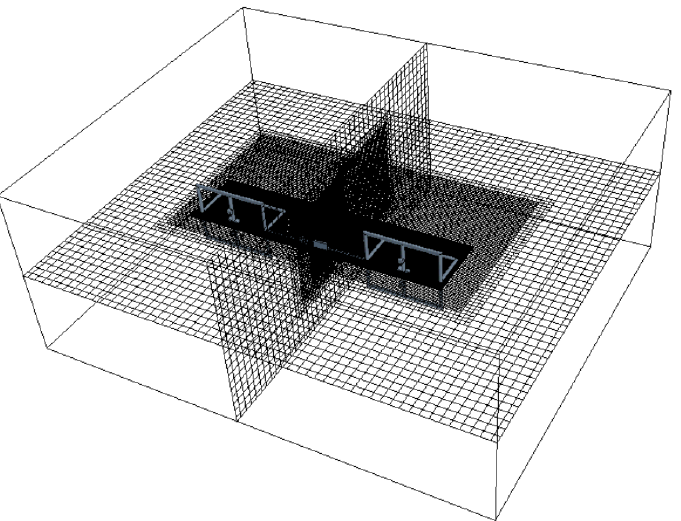
Figure 7. CFD domain with the mesh layout for heave; the domain size and refined region were adjusted when simulating surge and sway (developed with STAR-CCM+ [62]).